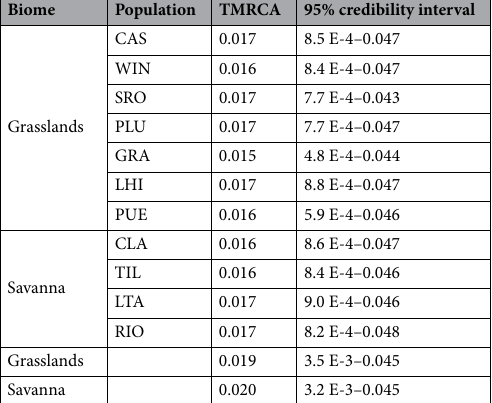
Table 3. Bayesian coalescent estimation of time to most recent common ancestor (TMRCA) among D.vittatus populations with 95% highest posterior density modeled assuming a relaxed molecular clock as implemented in BEAST. Times of divergence among populations are in million